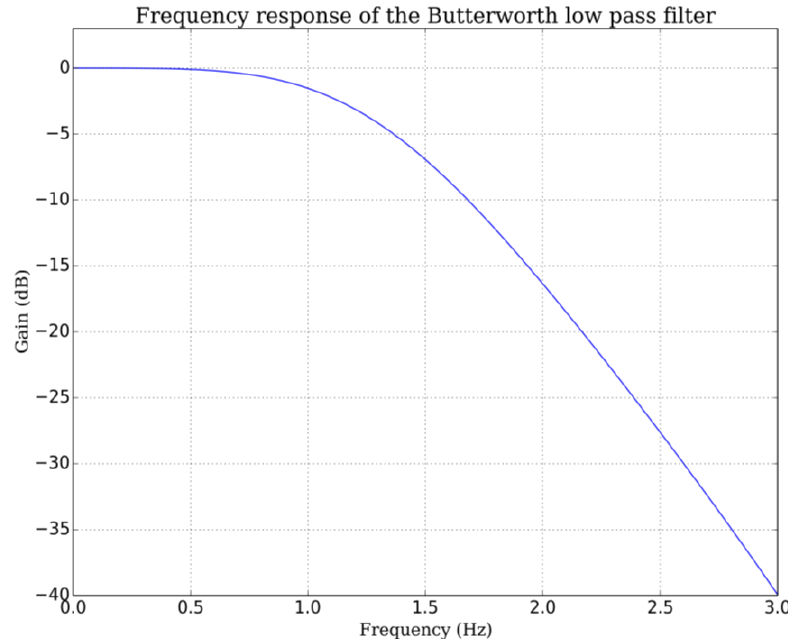
Figure 11. Frequency response of the Butterworth lowpass filter used for the breathing